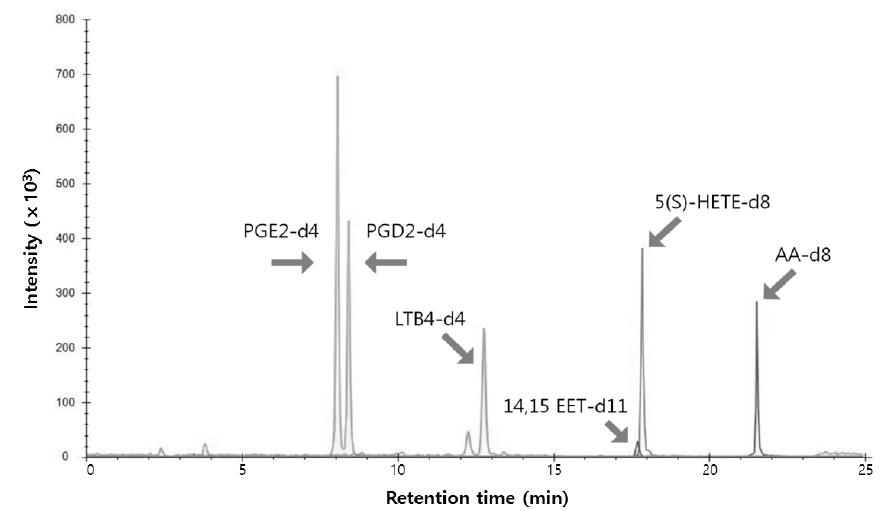
Figure 4. Merged multiple reaction monitoring data of six standards—PGE 2 -d4, PGD 2 -d4, LTB 4 -d4, 14,15-EET-d11, 5(S)-HETE-d8, and AA-d8. Table 2. Validation of the eicosanoid profiling method based on UPLC-MS/MS and the LOD and LOQ of each compound.